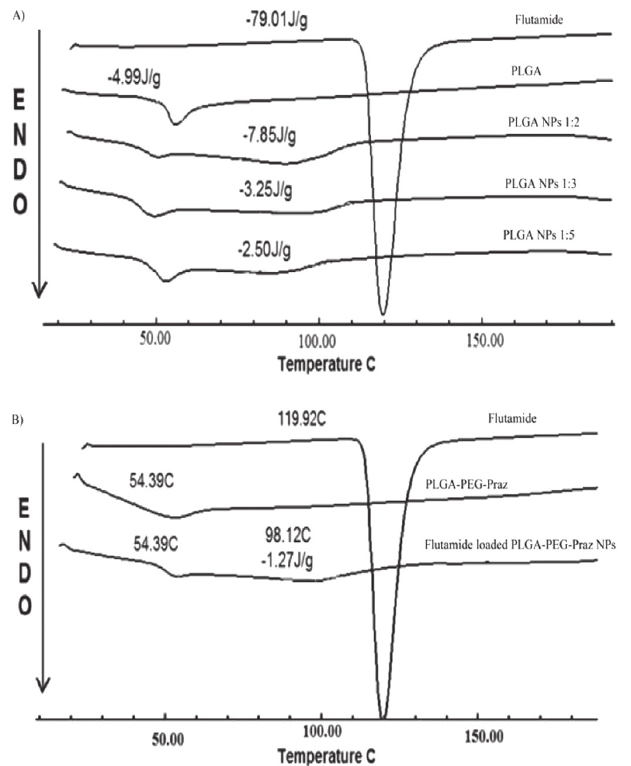
FIGURE 5 - DSC curve of the intact flutamide powder, PLGA, PLGA‑PEG‑Parz, physical mixture of drug: PLGA 1:3, nanoparticles of drug: PLGA 1:3, and PLGA‑PEG‑Parz nanoparticles.